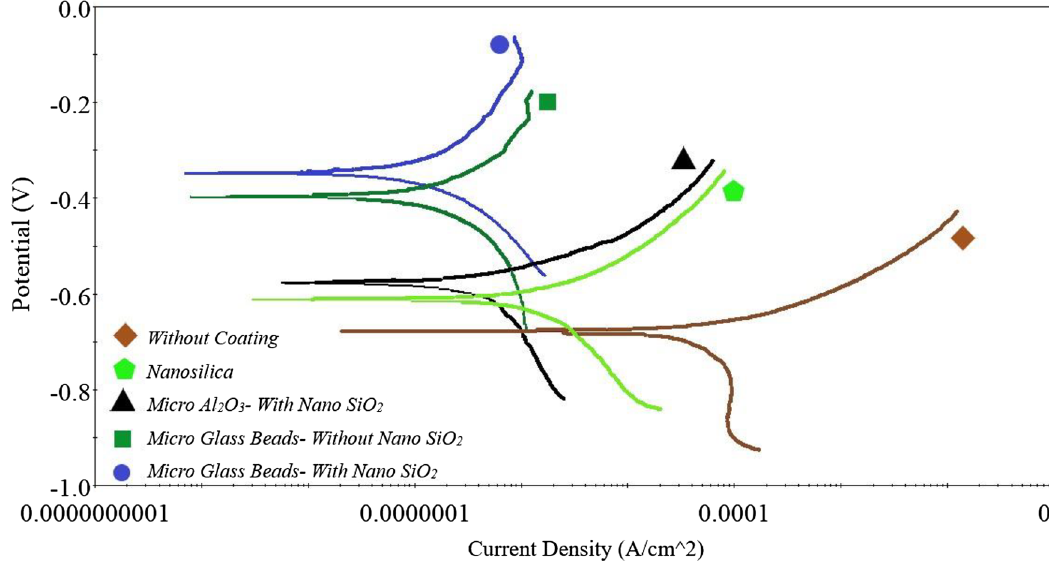
Figure 5. Comparison of potentiodynamic polarization curves of coated and uncoated samples.